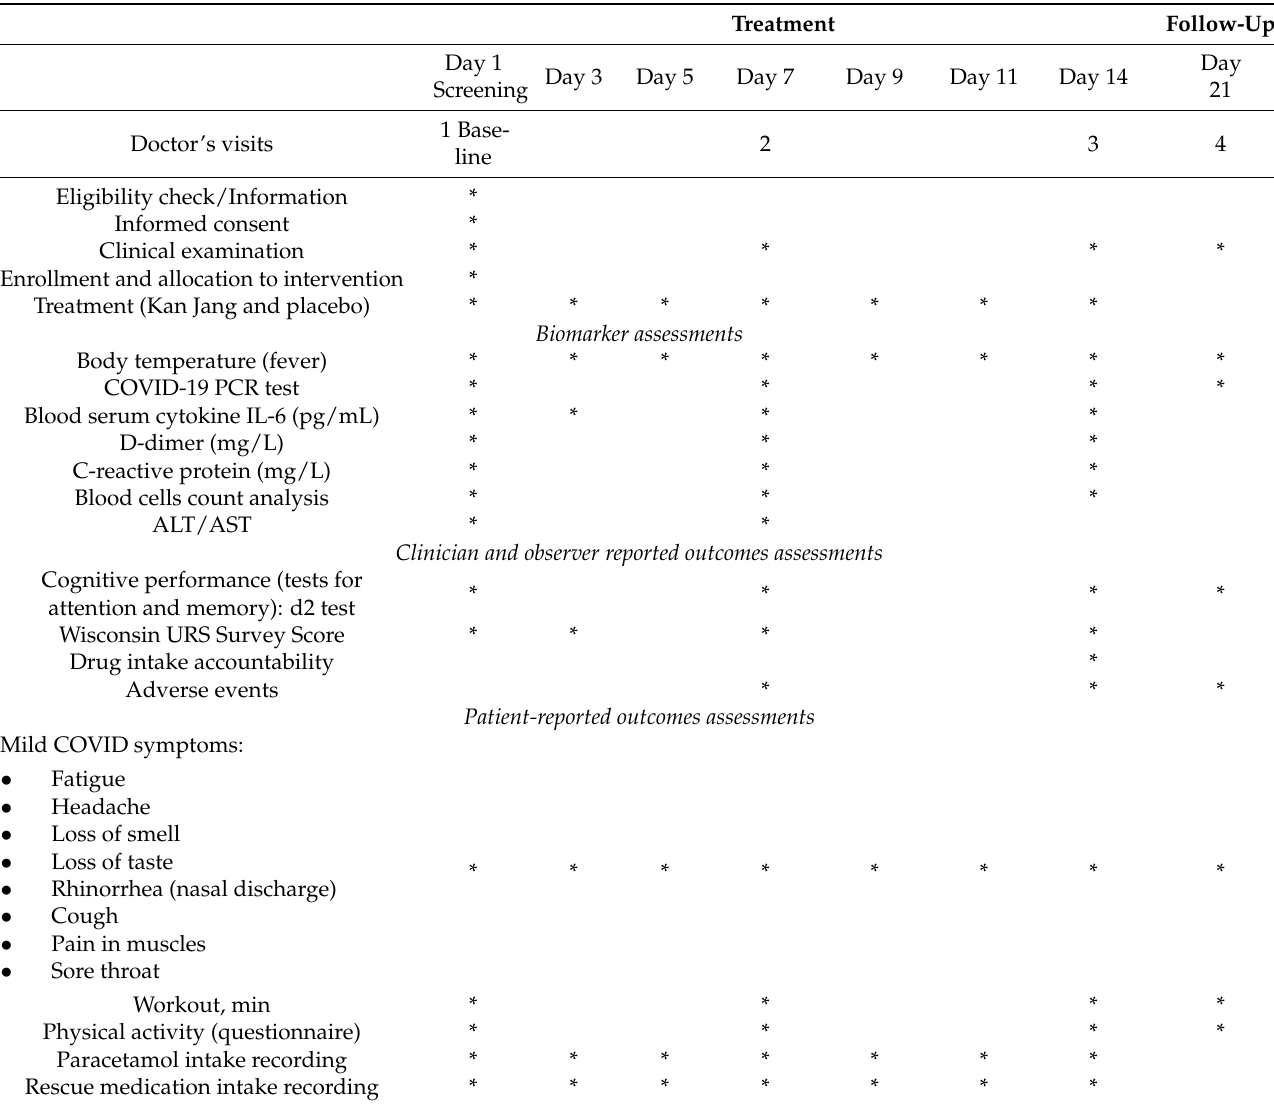
Table 3. Schedule of examinations and